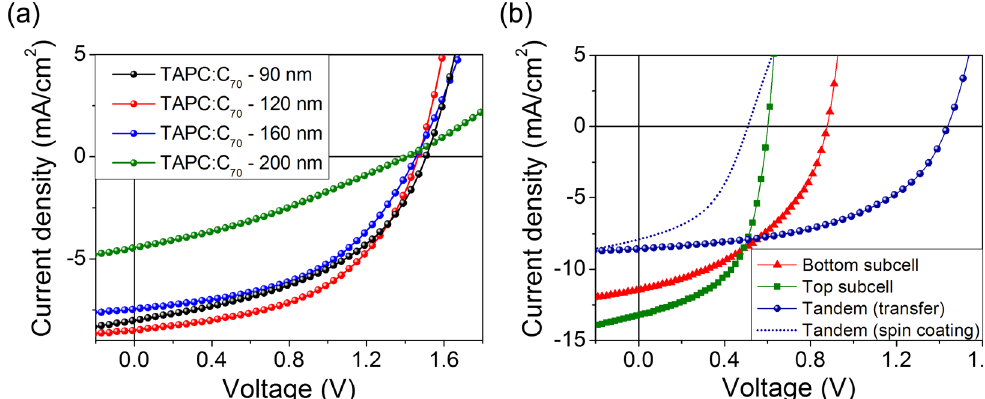
Figure 3. Current density vs voltage ( J – V ) characteristics of single-junction and tandem solar cells. ( a ) J – V characteristics of transfer-fabricated organic tandem solar cells with varying TAPC:C 70 thickness. ( b ) J – V characteristics of transfer-fabricated and spin-coated tandem cells with 120-nm-thick TAPC:C 70 layers, and two single-junction cells whose active layers are TAPC:C 70 and PCPDTBT:PC 70 BM,